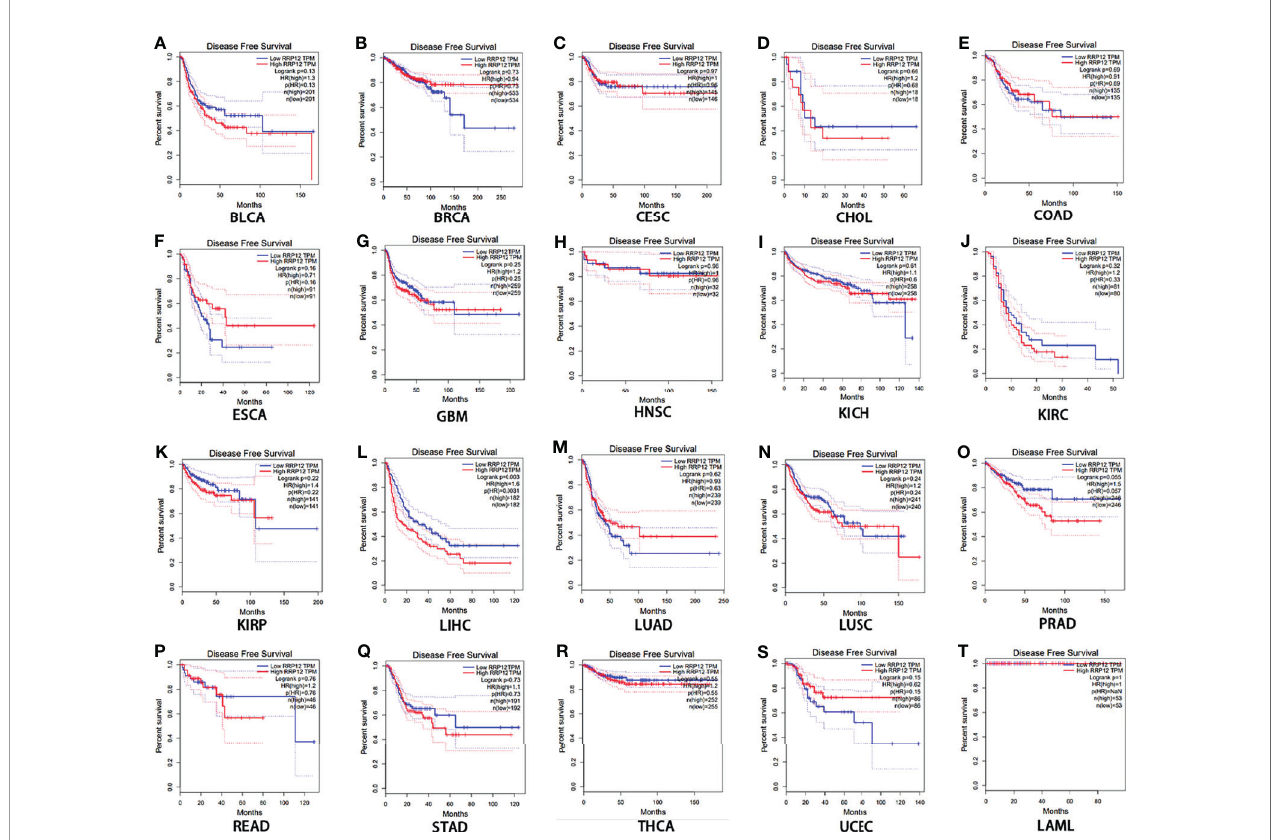
FIGURE 3 | The disease-free survival (RFS) analysis for RRP12 in various human cancers determined by GEPIA database. (A – T) The RFS plot of RRP12 in BLCA (A) , BRCA (B) , CESC (C) , CHOL (D) , COAD (E) , ESCA (F) , GBM (G) , HNSC (H) , KICH (I) , KIRP (J) , KIRC (K) , LIHC (L) , LUAD (M) , LUSC (N) , PRAD (O) , READ (P) , STAD (Q) , THCA (R) , UCEC (S) and LAML (T) . p<0.05 is statistically signi fi